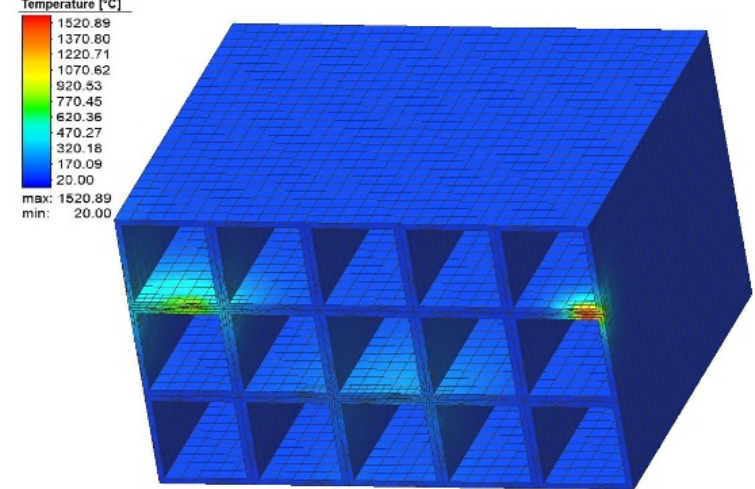
Figure 23. Temperature profile of vent panel assembly.